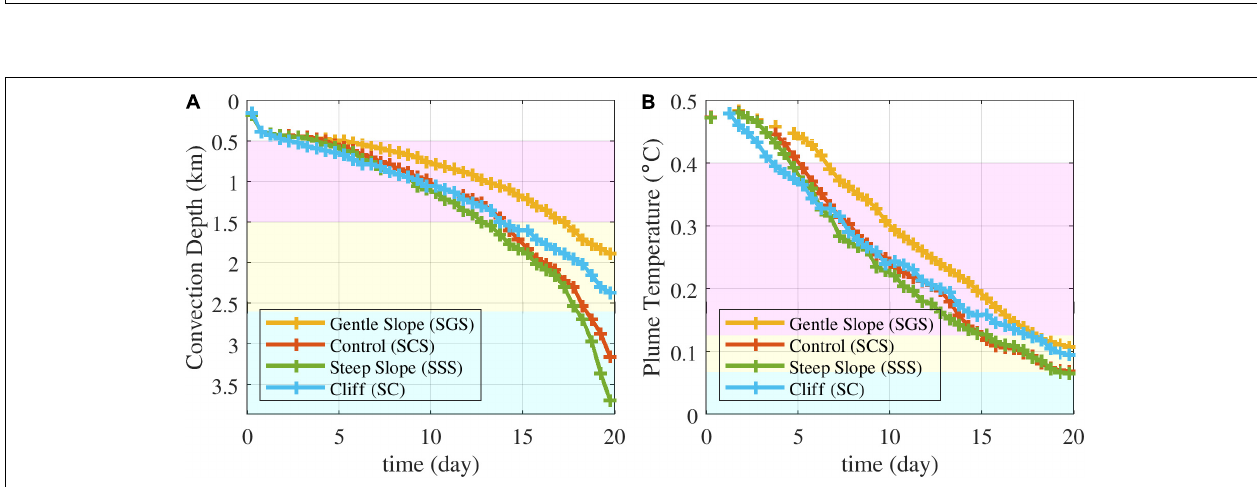
FIGURE 12 | Meridional sections of zonally averaged (A–D) potential temperature, (E–H) tracer concentration in the (A,E) SGS, (B,F) SCS, (C,G) SSS, and (D,H) SC experiments. The results of the SCS experiment were reprinted for comparing the differences according to the slope inclination.